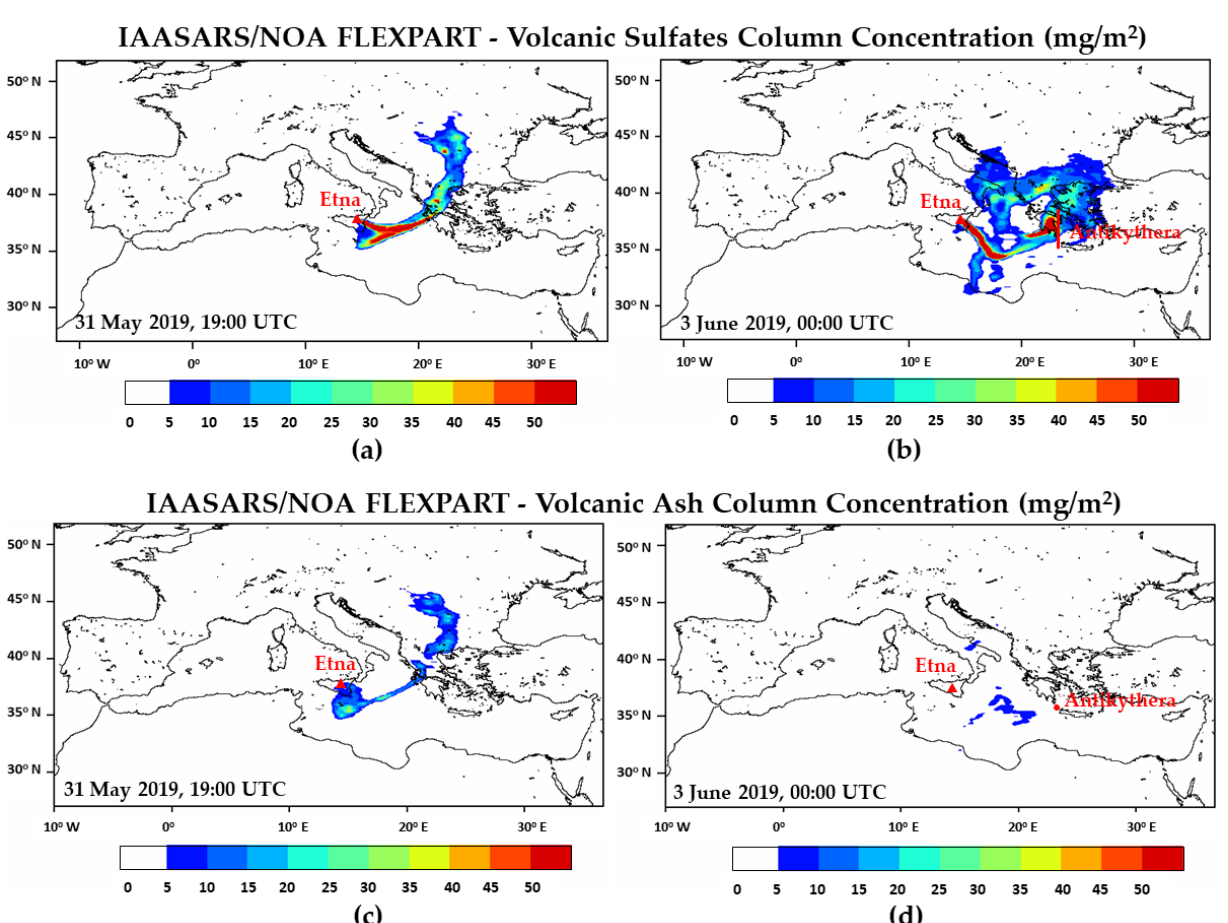
Figure 4. Simulated column concentration of volcanic particles (mg/m 2 ) originating from Etna for sulfates (up) and ash (down) on ( a , c ) 31 May 2019, 19:00 UTC and ( b , d ) 3 June 2019, 00:00 UTC, as simulated by FLEXPART-WRF. The location of the Etna Volcano is marked with a red triangle and Antikythera island with the red circle, while a vertical cross section above Antikythera is marked with a red line on ( b